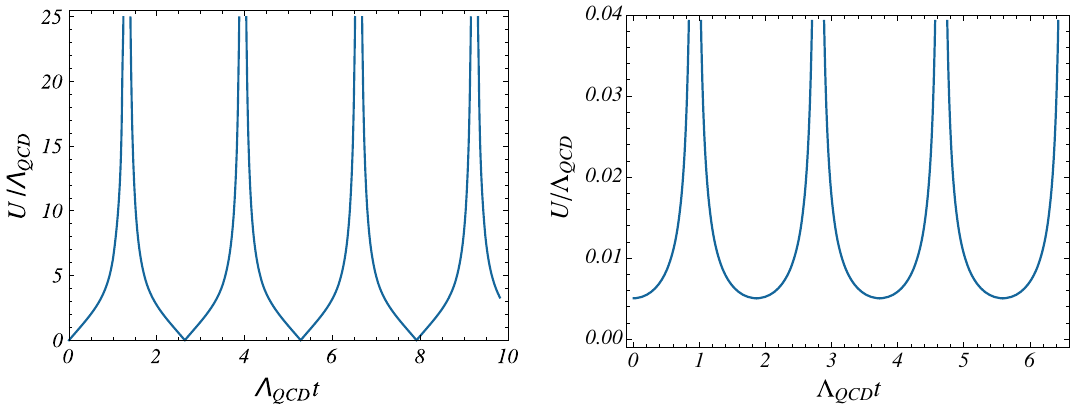
Fig. 3 AnillustrationofthehomogeneousQCDcondensateamplitude oscillations U = U ( t ) , with quasi-periodic singularities in the physical (cid:15) ad η , is shown for the chromoelectric ( Q ( U ) = 1) and the time t = chromomagnetic ( Q ( U ) = − 1) vacua solutions, respectively in the left